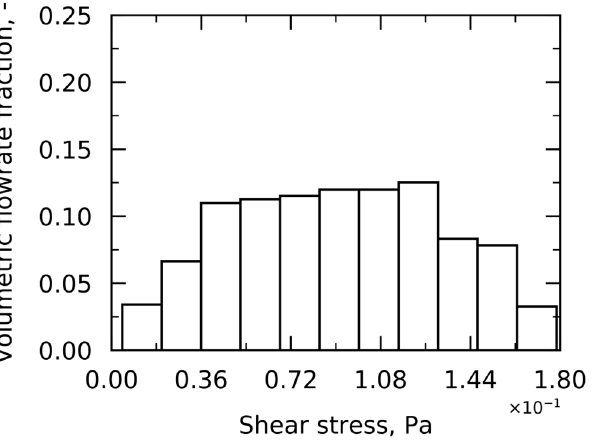
Figure 5. Shear stress distribution weighted on normalized volumetric flowrate under laminar conditions.